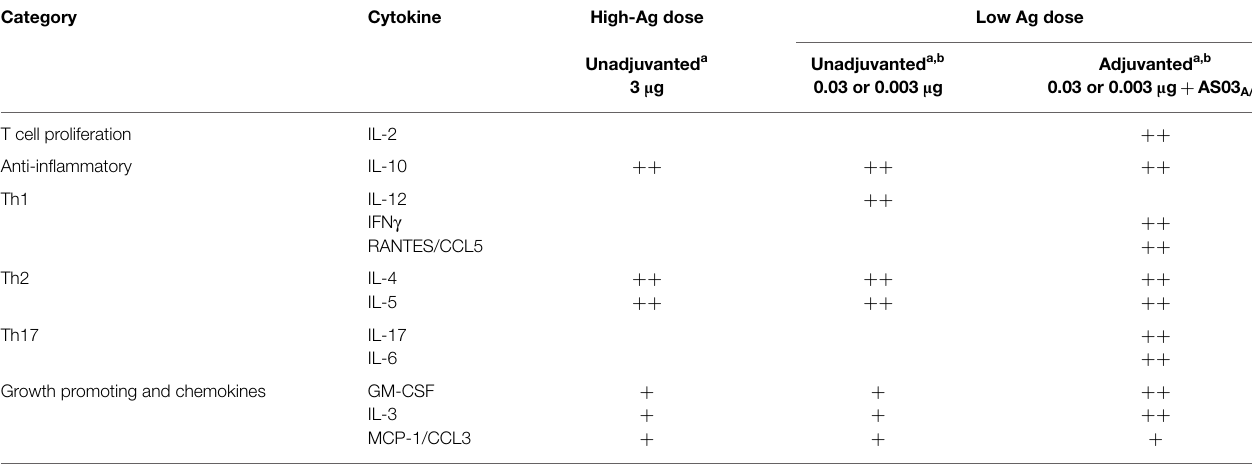
TABLE 1 | Summary of influenza-specific cytokine responses in the supernatants of restimulated splenocytes after two immunizations of unadjuvanted A/Uruguay/716/2007 H3N2 split vaccine or AS03-adjuvanted dose-sparing vaccines . Category Cytokine High-Ag dose Low Ag dose Unadjuvanted a Unadjuvanted